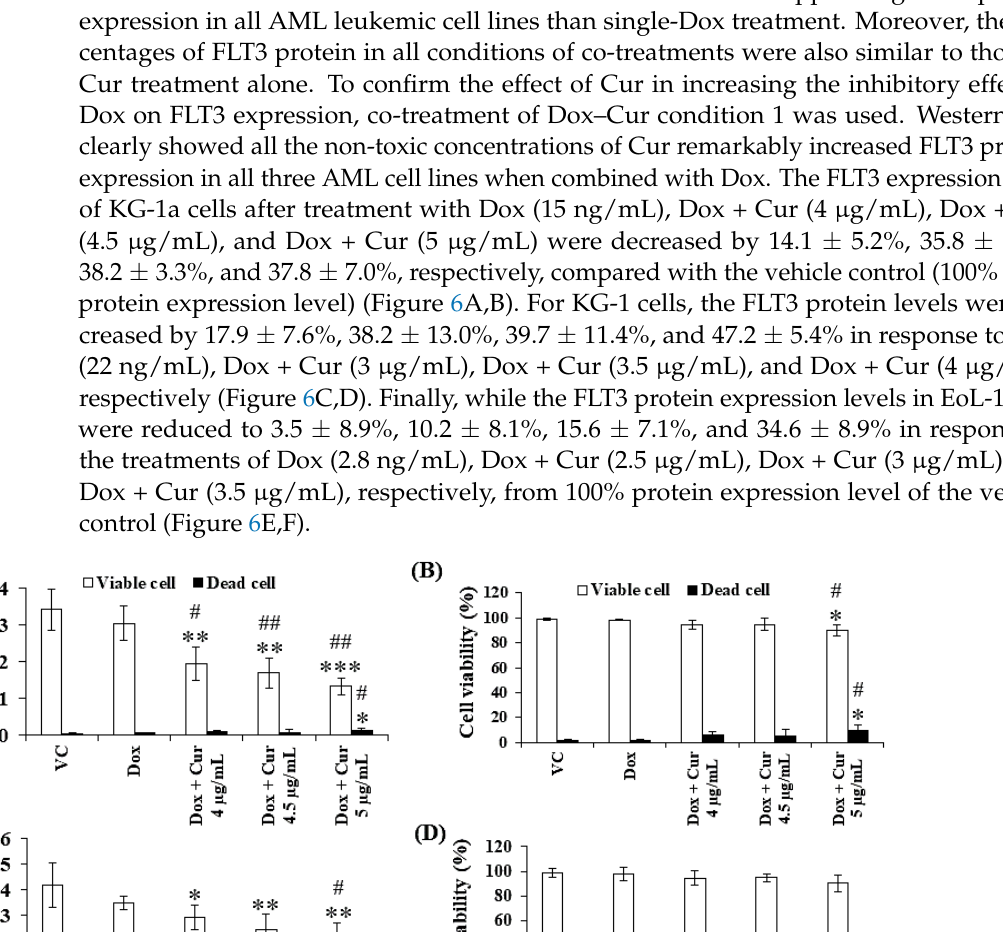
Figure 4. FLT3 protein expression of EoL-1 cells after treatment with Dox and combined treatment of Dox–Cur at concen- tration value of IC 20 for 48 h. Protein bands ( A ) and percentage ( C ) of FLT3 protein expression level of EoL-1 cells treated with DMSO (VC), Dox at concentration of 6 ng/mL, Dox–Cur condition 1 (3 ng/mL Dox + 3 μ g/mL Cur), Dox–Cur condi- tion 2 (0.7 ng/mL Dox + 4 μ g/mL Cur), Dox–Cur condition 3 (0.5 ng/mL Dox + 4.5 μ g/mL Cur), and Dox–Cur condition 4 (0.4 ng/mL Dox + 5.5 µ g/mL Cur) for 48 h. Whole protein lysates (80 µ g/lane) were loaded onto SDS-PAGE. Protein bands ( B ) and percentage ( D ) of FLT3 protein expression level of EoL-1 cells treated with DMSO (VC), Cur (3 µ g/mL), Cur (4 µ g/mL), Cur (4.5 µ g/mL), and Cur (5.5 µ g/mL) for 48 h. The data are shown as Mean ± SD from 3 independent experiments. The significance of mean differences was assessed using one-way ANOVA. * p < 0.05, ** p < 0.01, and *** p < 0.001 compared with VC. ## p < 0.01 and ### p < 0.001 compared with single-Dox treatment.